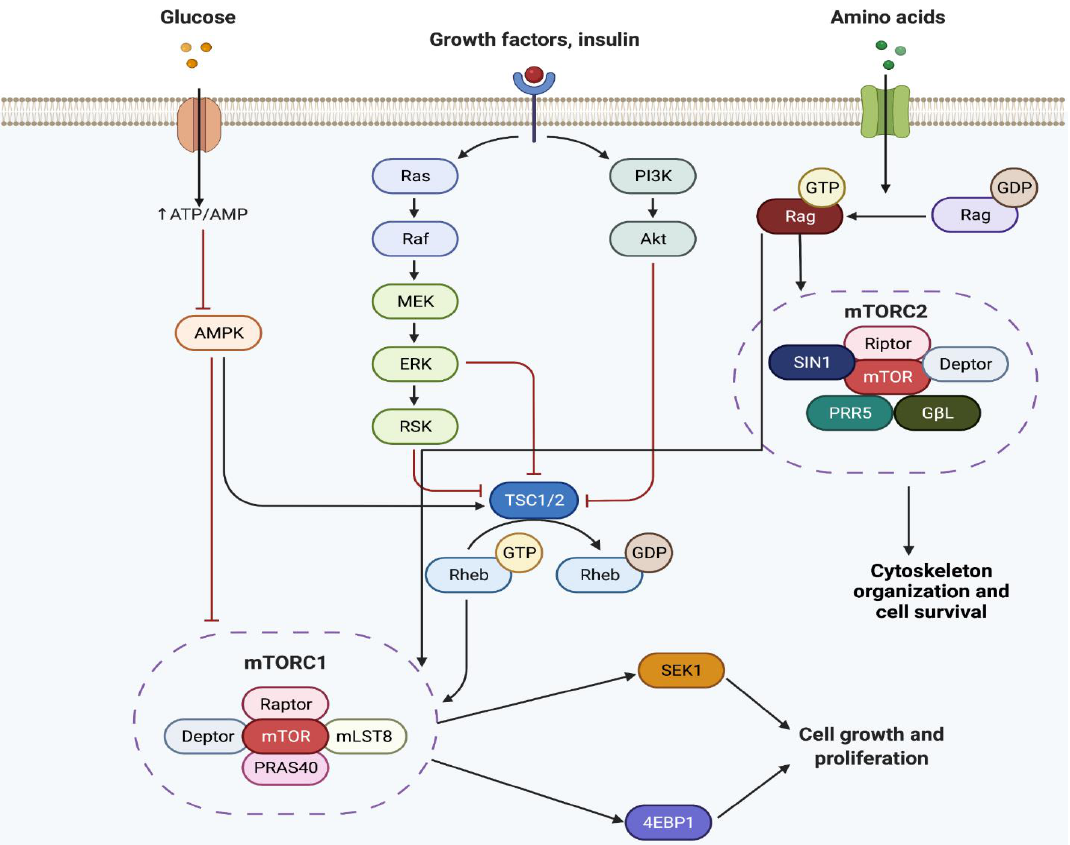
Figure 2. mTOR mechanism pathway. Glucose and growth factors activate a series of pathways that either activate or inhibit (AMPK) mTORC1. Amino acids can either activate mTORC1 or mTORC2, which lead to cytoskeleton organization and cell survival or cell growth and proliferation (see text for more details). The figure was prepared by software provided by Biorender.com (accessed on 3 March 2022)